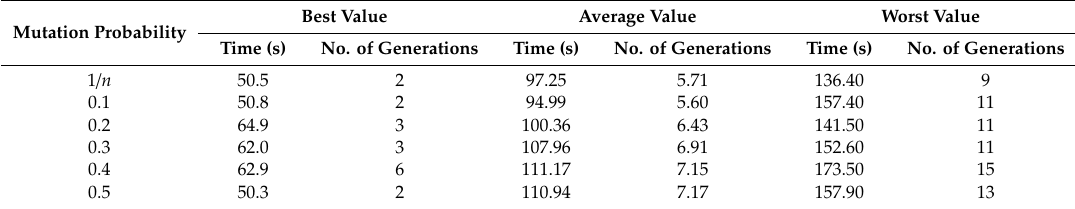
Table 7. E ff ect of the mutation operator for test case generation using the MSGA.